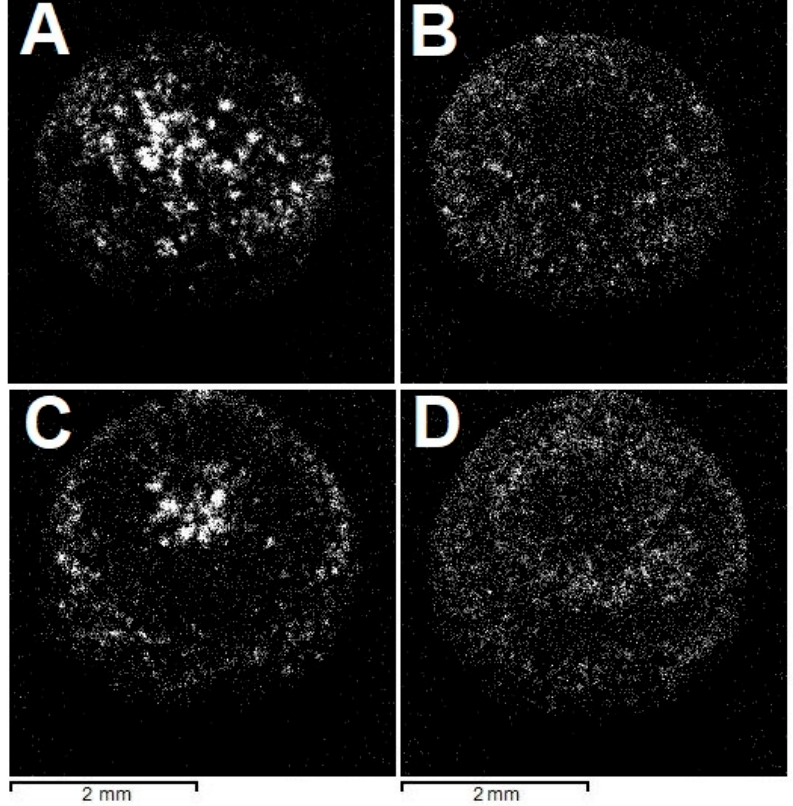
Figure 4. Spatial distribution of (unindexed) Bragg reflections, highlighting the radial fibrous struc- ture of the studied ballases; see text for detail. ( A , B )—“large” ballas, ( C , D )—“small”. Grain orientation was investigated using EBSD. On the “large” sample, both the whole polished surface and a smaller part in the central region were analyzed; on the “small” ballas, only a relatively small central region was studied, but with a relatively high spatial resolution of 1.7 µ m. Stereographic diagrams of both samples are qualitatively similar, showing well-defined clustering of reflections (Figure 5). Detailed EBSD mapping of a region of the “large” ballas reveals that reflections form an elongated cluster in the {110} plane. This observation is in line with the results of the analysis of the surface features, suggesting the rotational splitting of crystalline fibers comprising ballas and the presence of growth-related autodeformations arising from rotation and bending [28,29]. In the studied case, the rotation occurs in the {110} direction. The angular scatter of the reflections